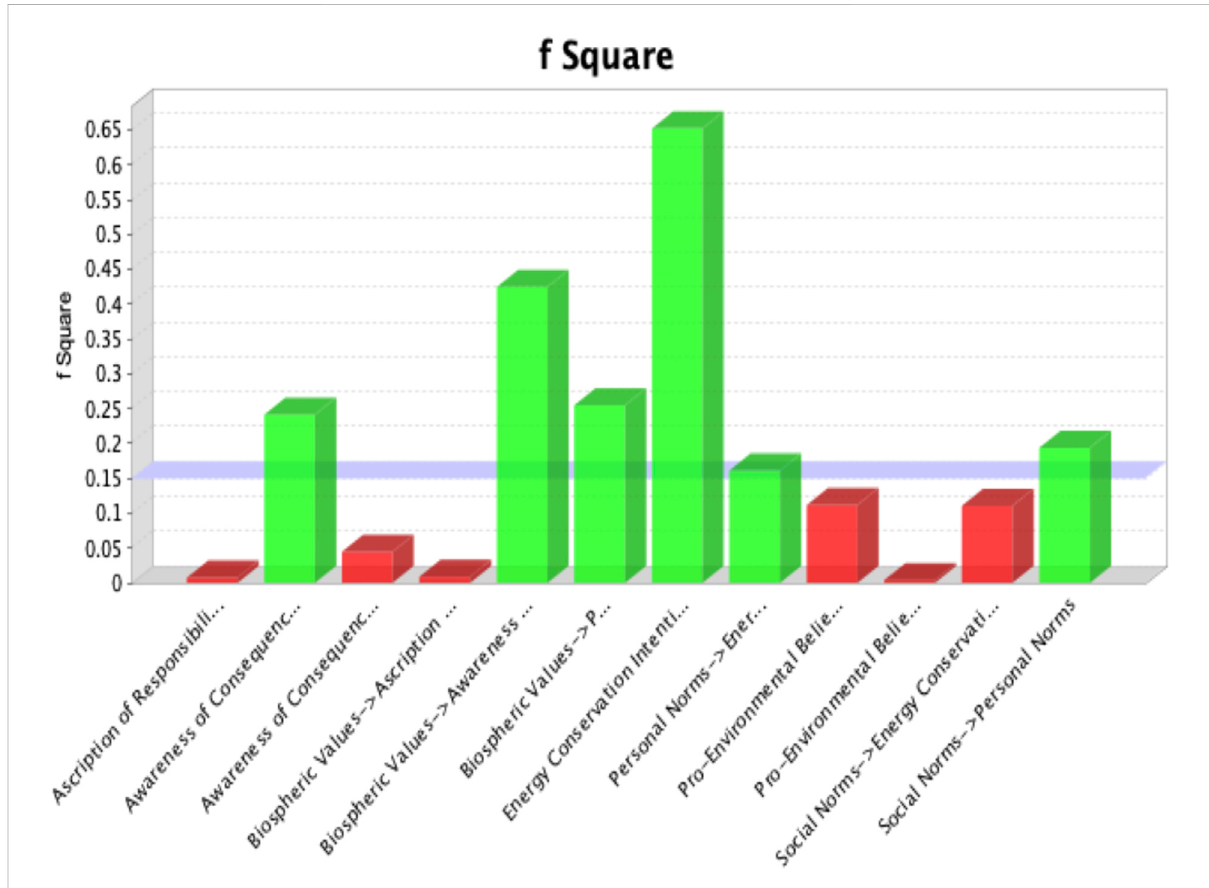
FIGURE 3 Effect size ( f 2